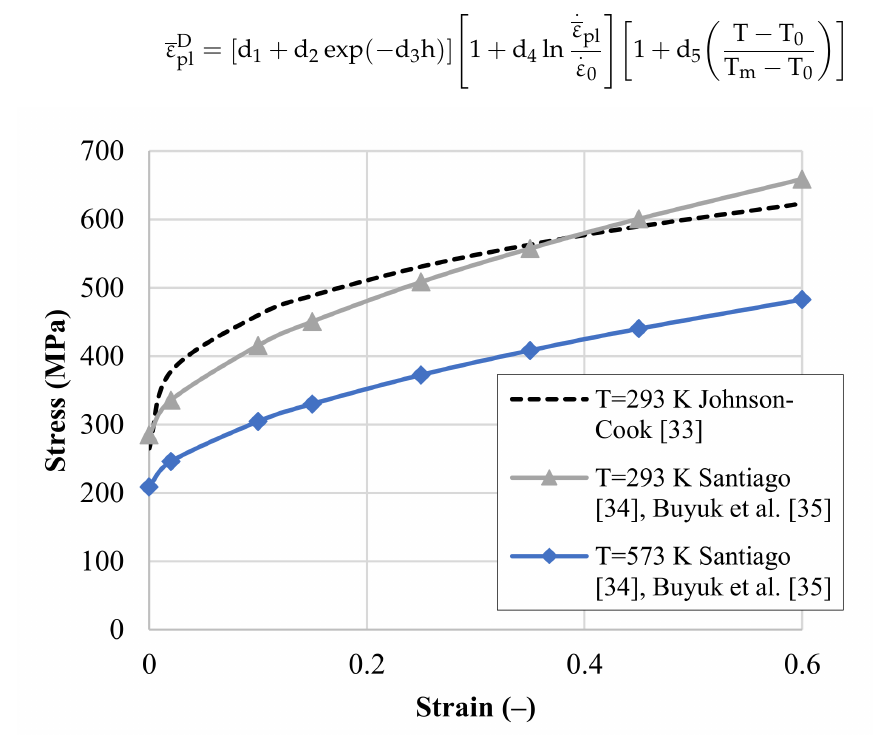
Figure 4. The calibrated material model (JC) based on experiments for the 2024-T3 aluminum alloy by Santiago [34], Buyuk et al. [35] for two different temperatures and strain rate of 1 l/s compared to experiments by Johnson and Cook [33]; (-) stands for a dimensionless parameter.